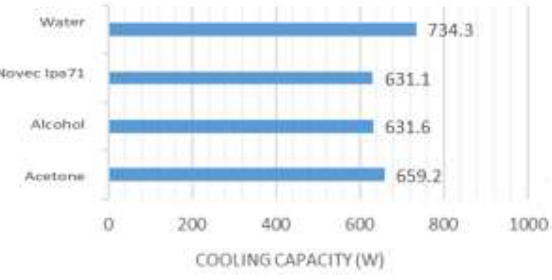
Fig. 10. Comparison of cooling capacity, load 1 000 W, volume 80